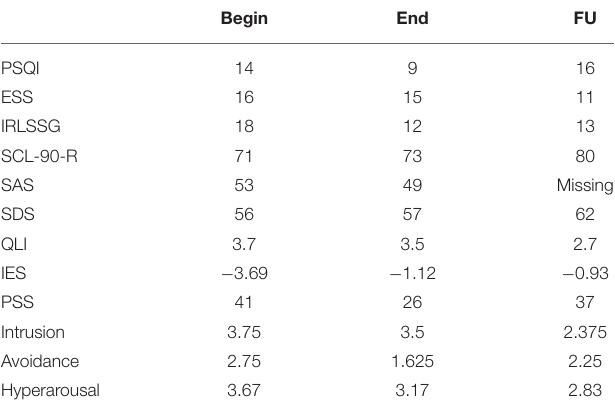
TABLE 1 | Mrs. L.’s scores of psychological